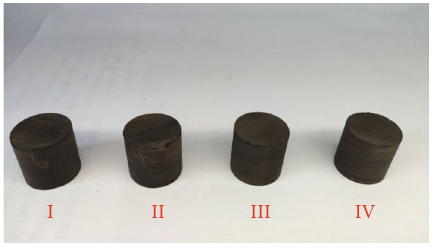
Figure 1: Oil shale